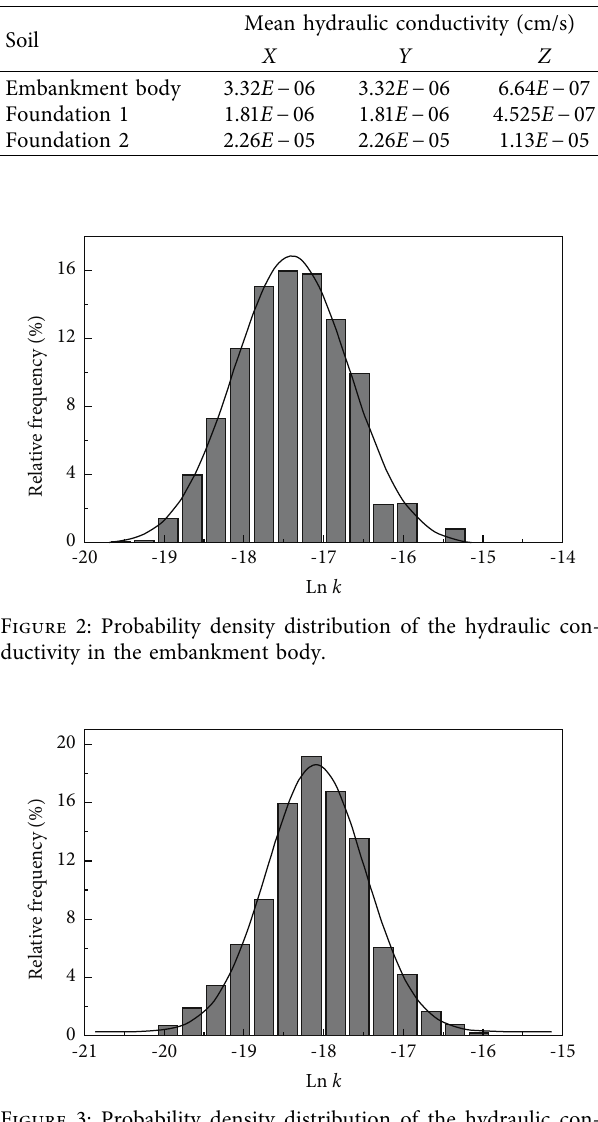
Figure 1: Dimension of the embankment. Table 1: Hydraulic conductivity of the embankment soil.